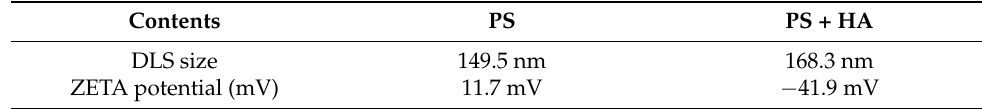
Table 1. The particle size & Zeta potential of PS, & PS +